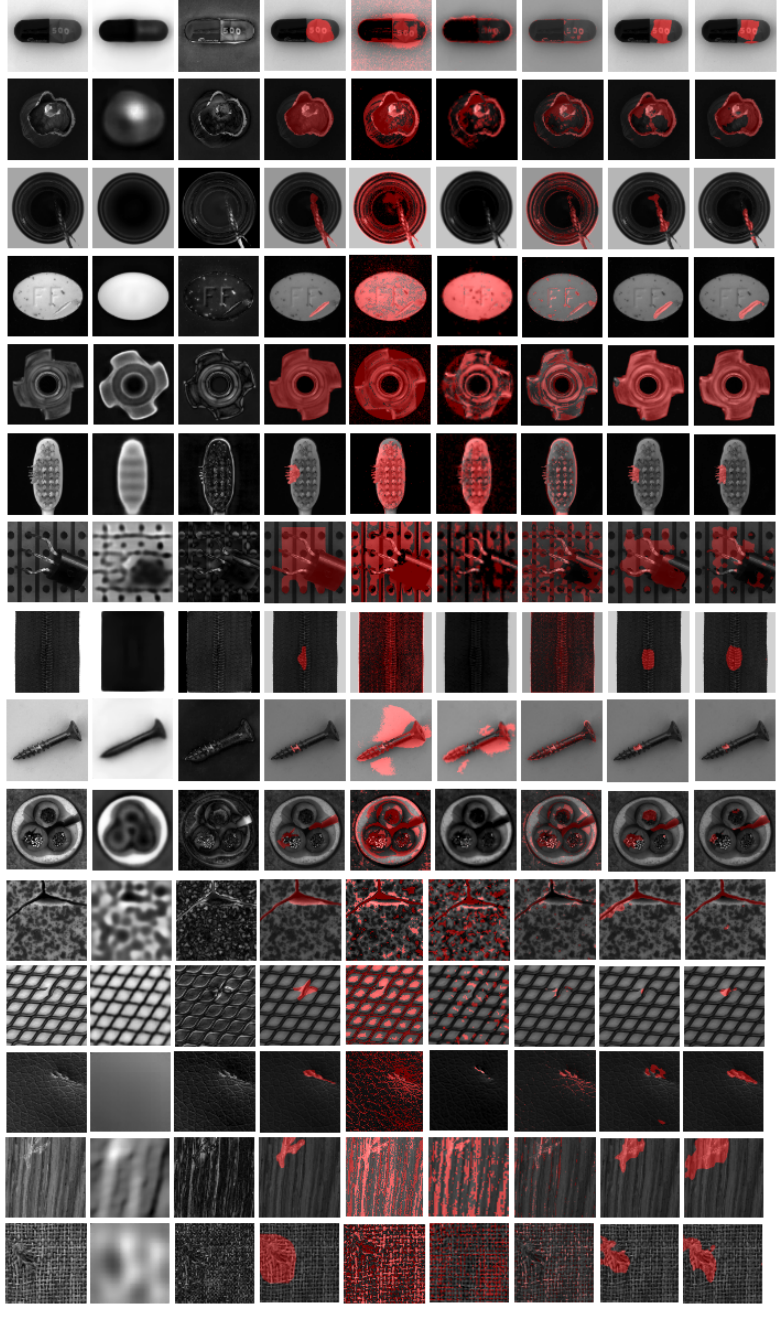
Figure 6. Qualitative results of all object categories. From left to right: original image, reconstructed image from AE, difference image, ground truth, results from PCA, unsupervised AnoGan, unsuper- vised AE, results from mean teacher, and results from our proposed